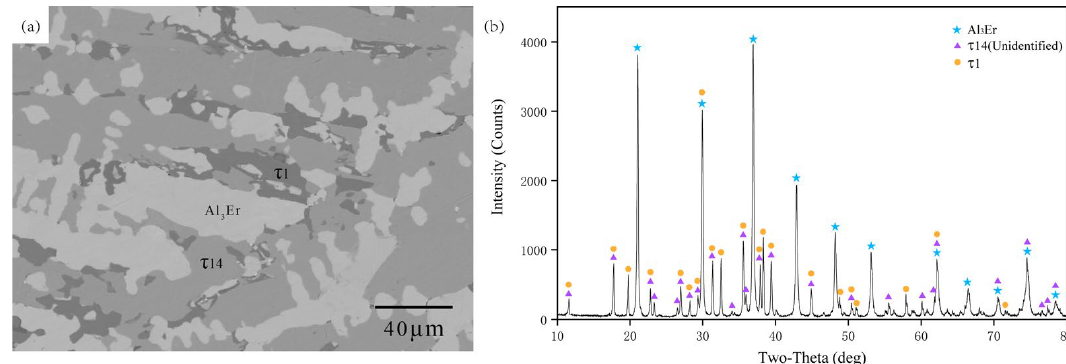
Figure 9. The sample B3 ( a ) BSE image ( b ) XRD pattern.